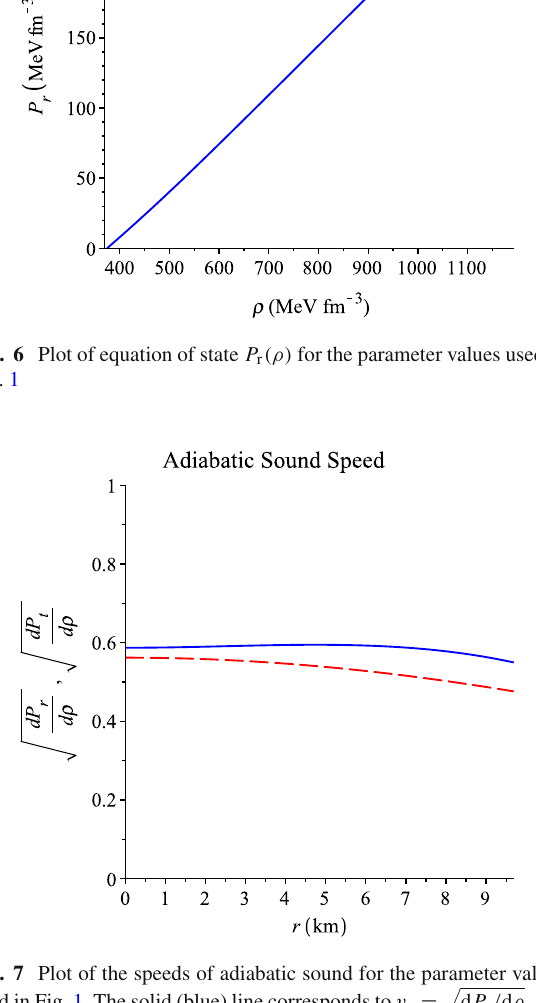
(cid:10) d P r / d ρ , and (cid:10) d P t / d ρ . The solid (blue)